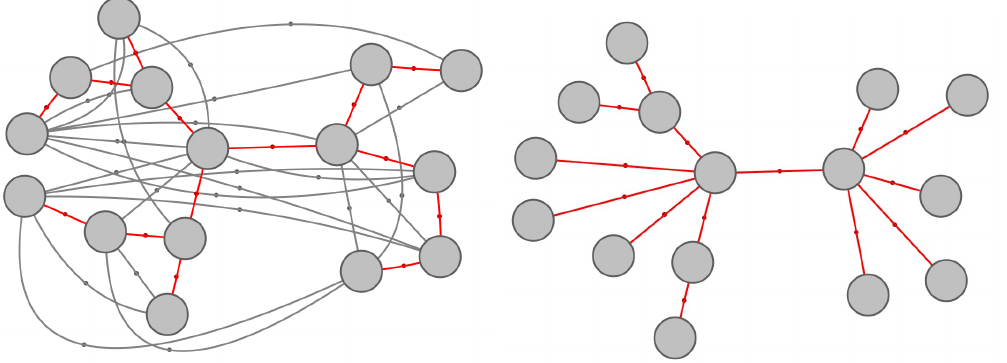
Figure 4: The original graph with first spanning tree (on the left) and the resulted spanning tree (on the